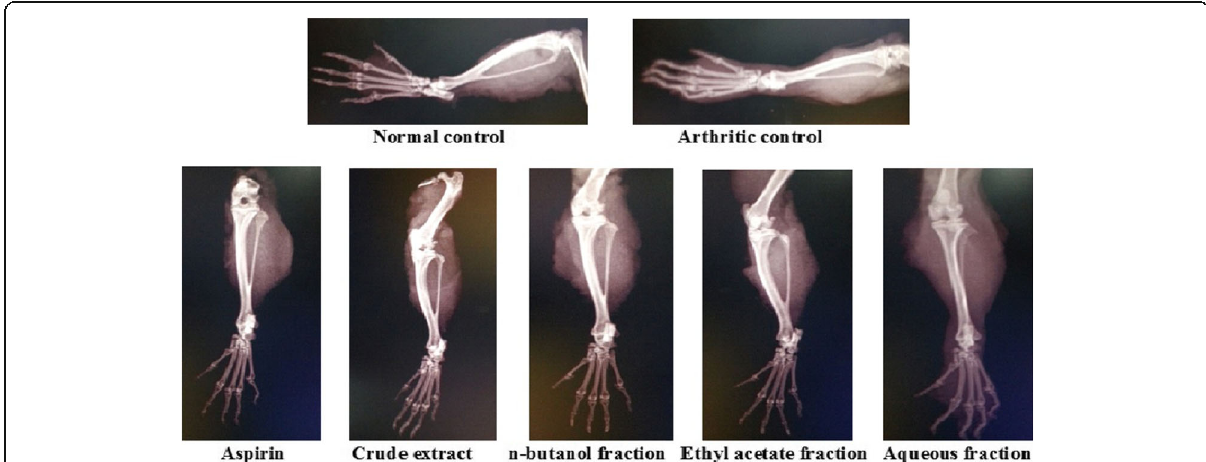
Fig. 5 Radiographic analysis of CFA induced arthritis in Sprague Dawley rats at 15th day of treatment after CFA injection